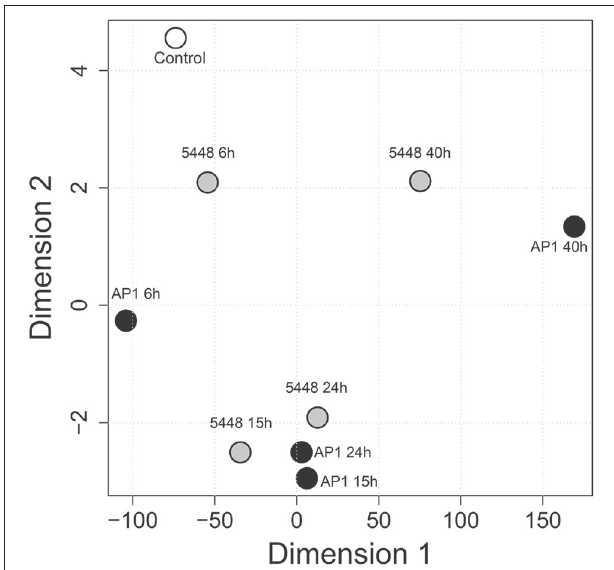
FIGURE 5 | Multidimensional scaling (MDS) visualizing global across-group changes in hematologic parameters during the 40h time course of infection. The analysis is based on median values of absolute counts of WBC, LYM, GRA, MON, PLT and the GRA/LYM ratio in peripheral blood ( n = 13–15 mice per group, using data combined from five independent complete time course experiments featuring three mice per treatment), obtained with a VetScan hematology analyzer as described in Methods. Each circle represents the centroid of the values of the respective groups of mice. The numbers indicate the time after infection (h). AP1 infection: black fill; 5448 infection: gray fill; uninfected controls: white fill.